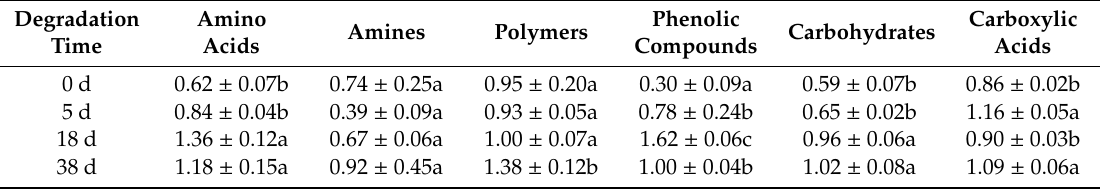
Table 5. Variance analysis of utilization of the six groups of carbon sources (amino acids, amines, polymers, phenolic compounds, carbohydrates and carboxylic acids) located in the BIOLOG ECO plate by the associated bacterial community.